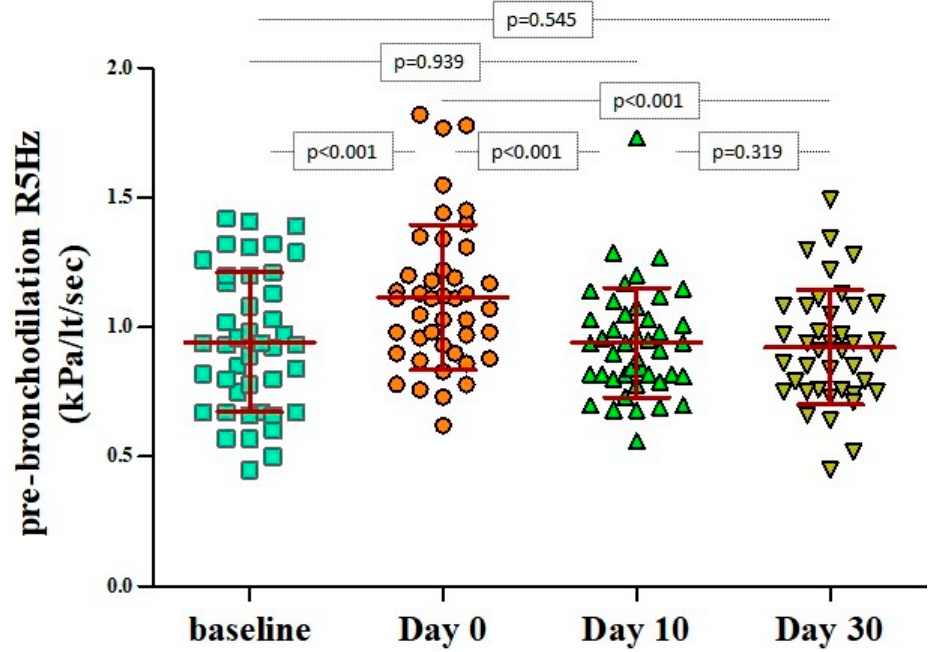
Figure 1. Pairwise comparisons of R5Hz values at baseline, on day 0 (beginning of the wheezing episode), and 10 and 30 days after. The bars and in-between lines represent the mean and standard deviation (SD). All pairwise comparisons are presented with p -values that have been estimated with paired Student’s t-test.; Pulmonary resistance (R) at 5 Hz (R5).